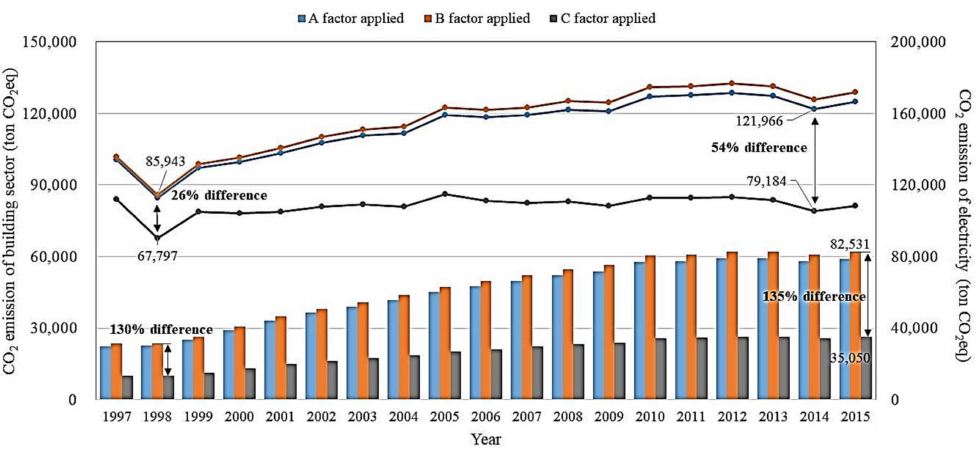
Figure 17. Comparison of greenhouse gas emission in the building sector by electric power emission